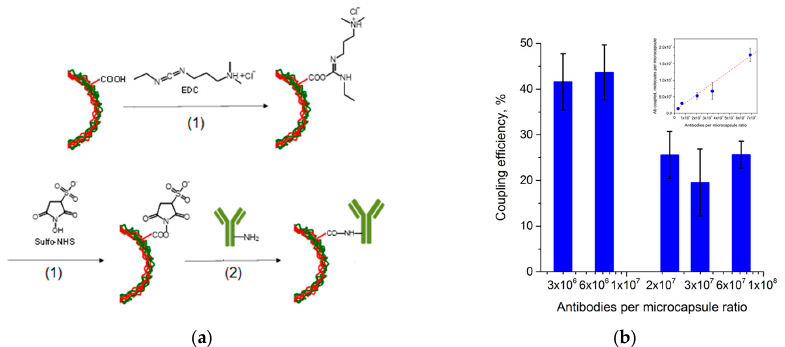
Figure 3. Coupling of antibodies to the microcapsule surface: ( a ) the scheme of the microcapsule surface activation (1) and antibody coupling (2); ( b ) antibody coupling efficiency, the data on the coupling yield are presented in the inset.